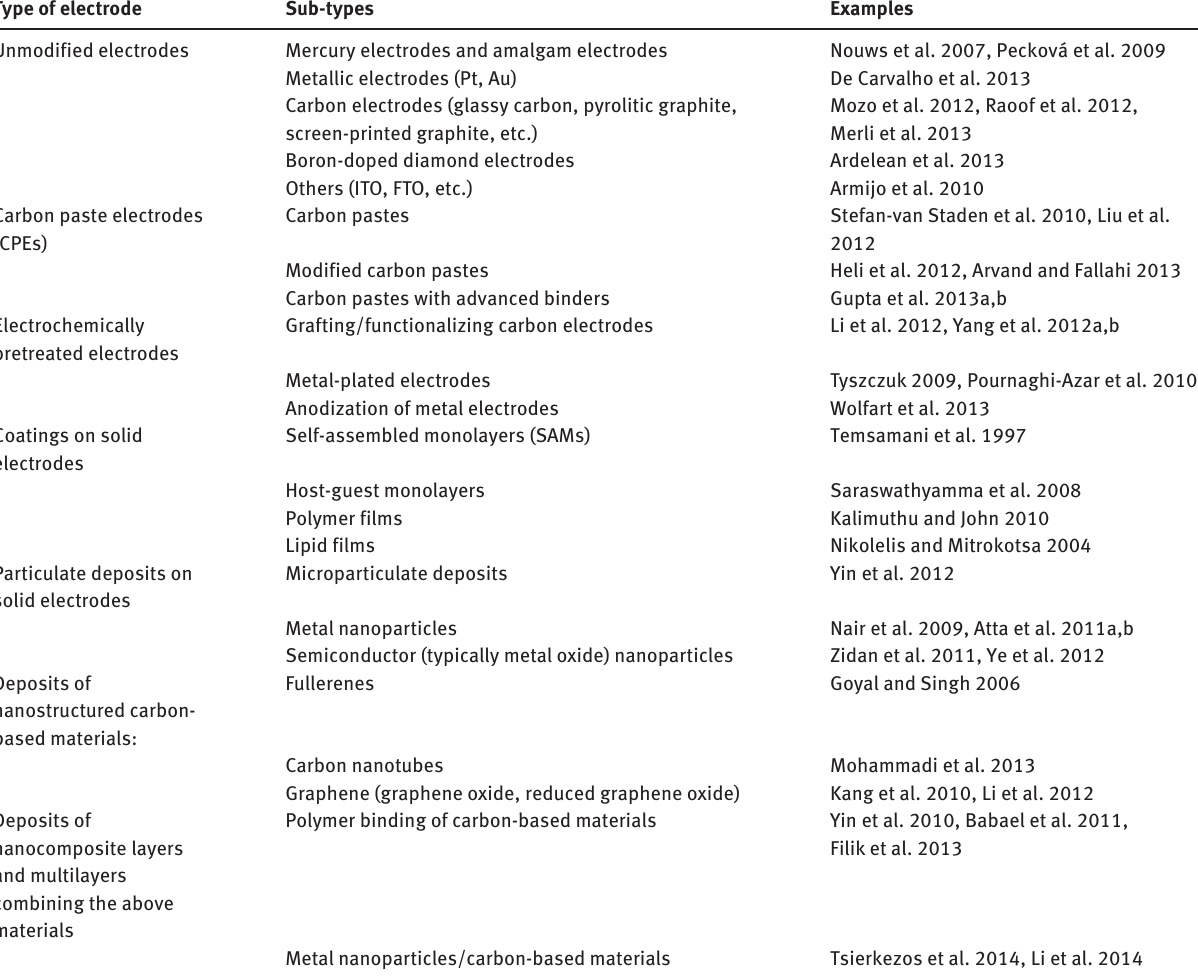
Table 1 Summary of the main types of electrodes used for voltammetric and/or amperometric screening of pharmaceuticals. Type of